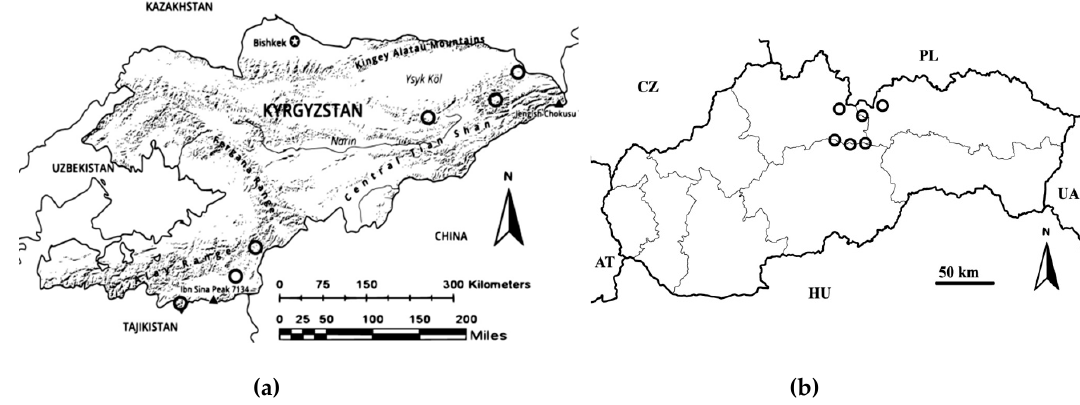
Figure 2. Maps of sample sites in ( a ) the Tian-Shan mountains (Kyrgyzstan) and ( b ) the Tatra mountains (Slovakia). The sample sites are displayed as circles.